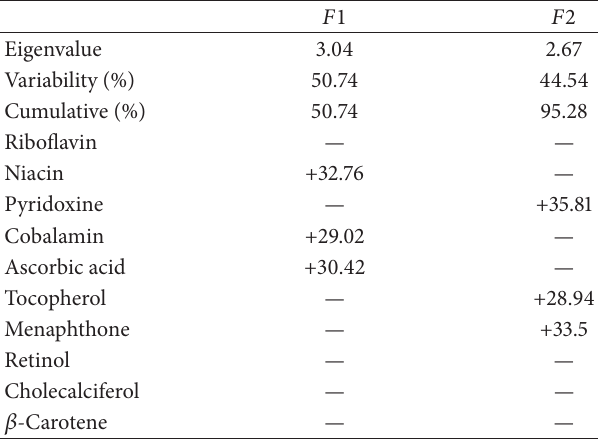
Table 4: Discriminate factors of principal components analysis based on vitamin contents of okra